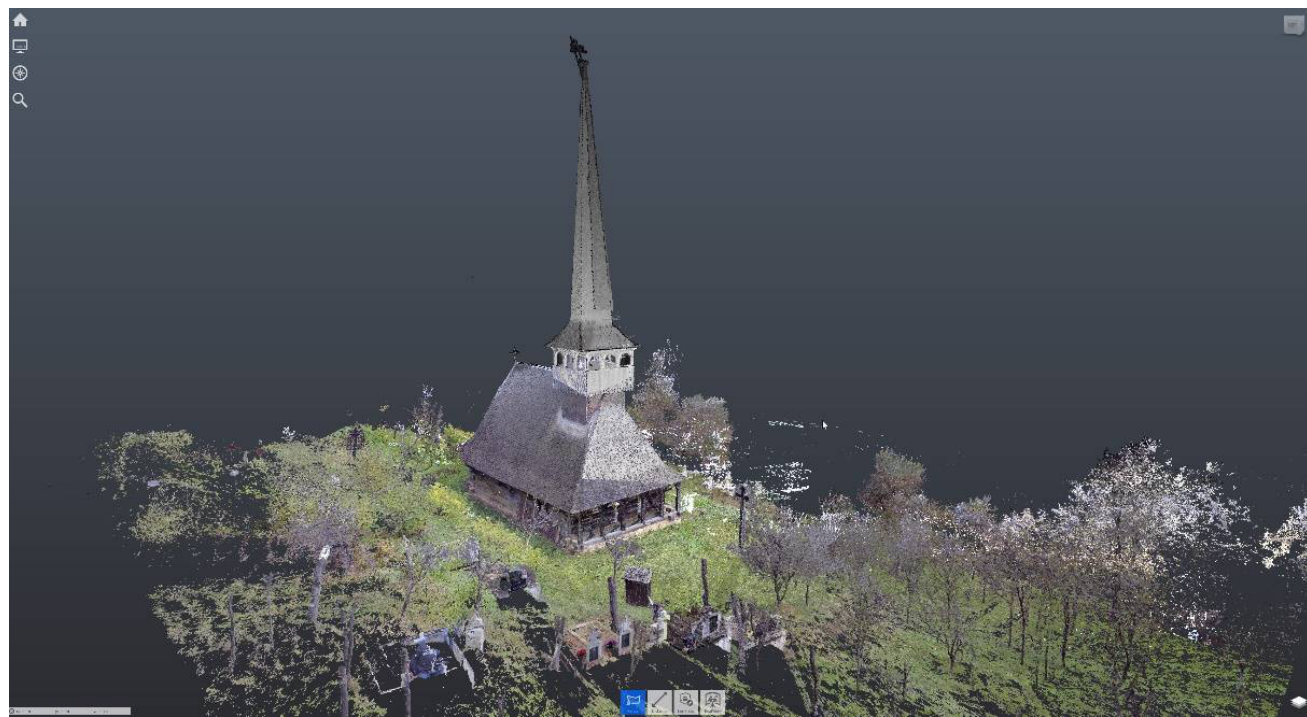
Figure 8. Voivodeni wooden church point cloud and its surroundings, resulted from 3D scanning.